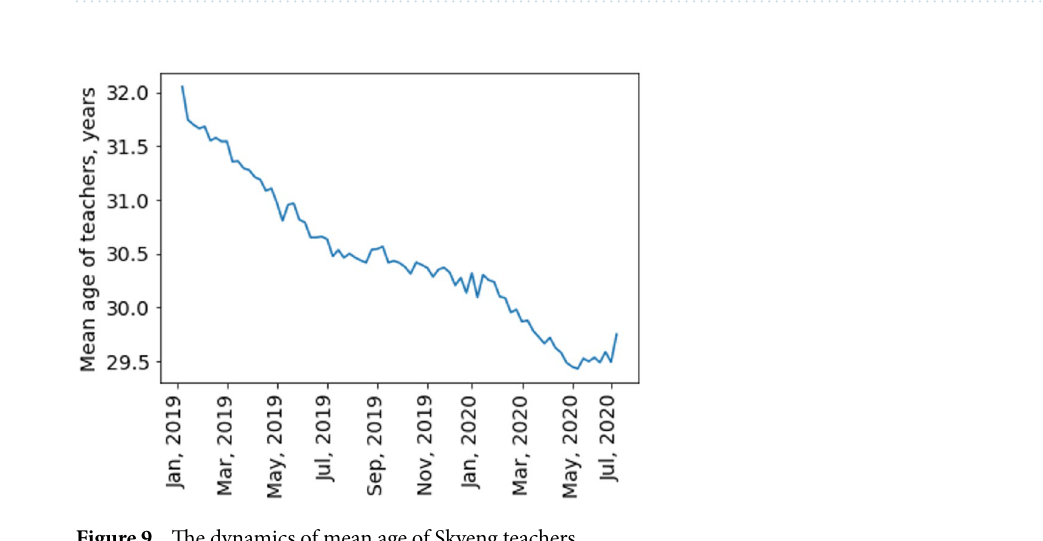
Table 1. The number of teachers in different age categories with respect to their gender (values were computed at 2019, January).